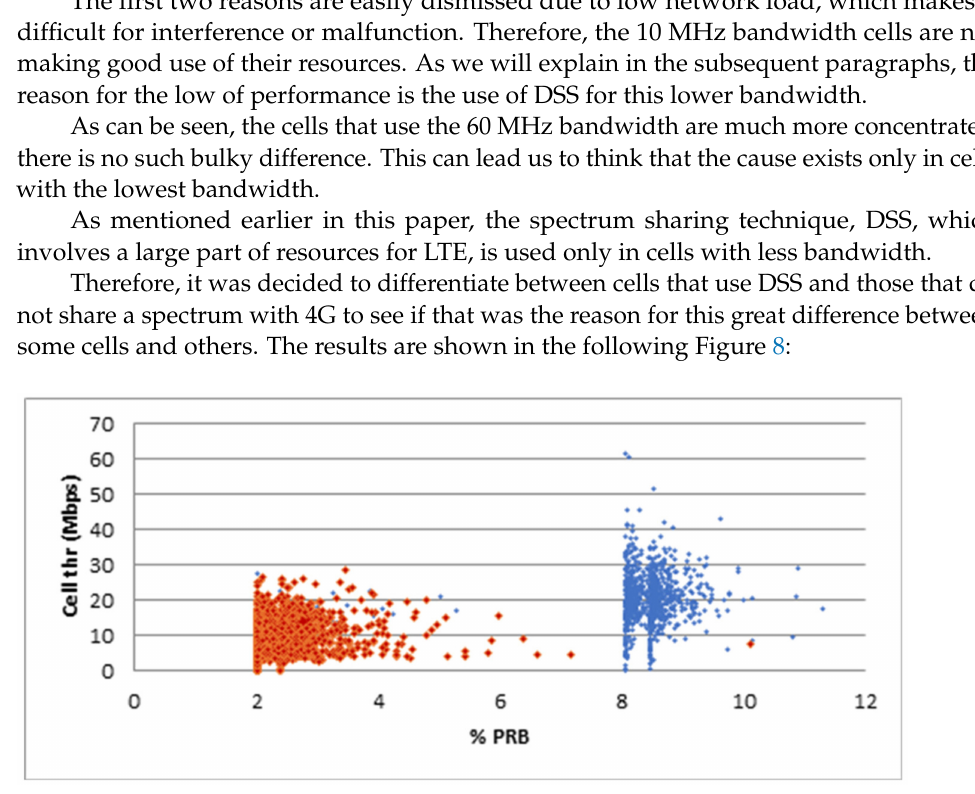
Figure 8. Difference between DSS use and not using